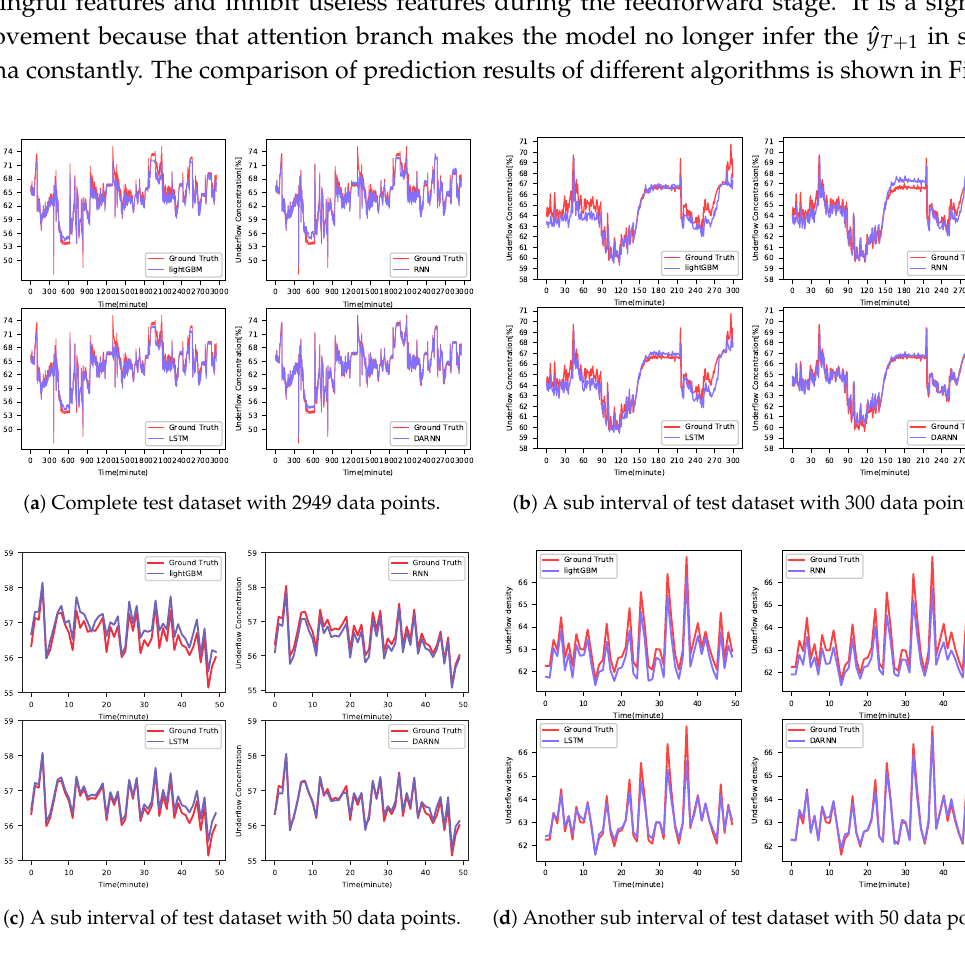
Figure 6. ( a ) The image shows all the data in the test set. ( b ) The image shows 300 pieces of data from the test set. ( c , d ): The image shows 50 pieces of data from the test set. In each image, LightGBM (upper left), RNN (upper right), and LSTM(lower left) are compared with DARNN (lower